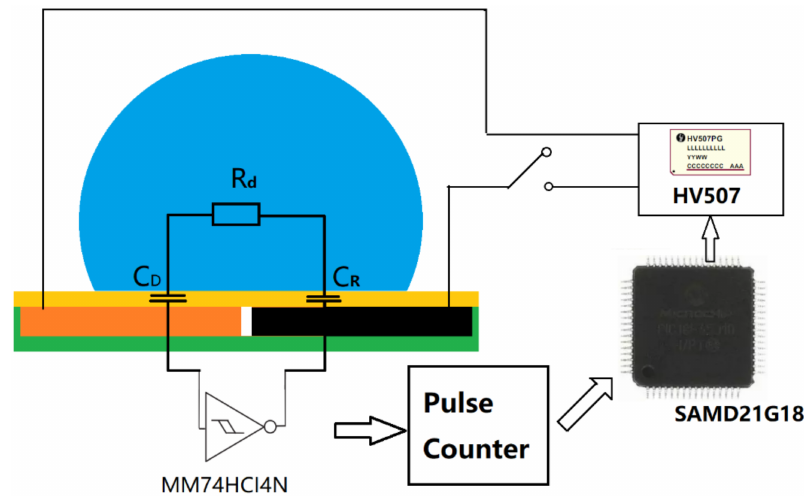
Figure 3. Schematic diagram showing the capacitance measurement circuitry. C D and C R are the capacitor generated by the droplet with the driving and reference